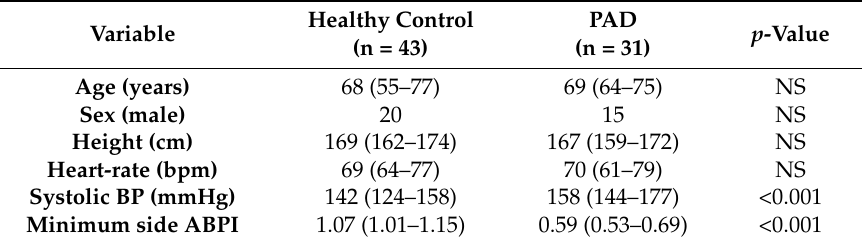
Table 2. Study participant demographics. NS: Non-significant.